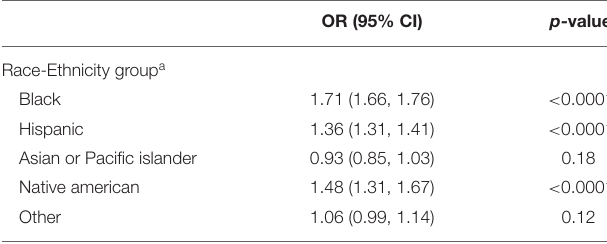
TABLE 3 | Multivariate analysis of major limb amputation, by race-ethnicity